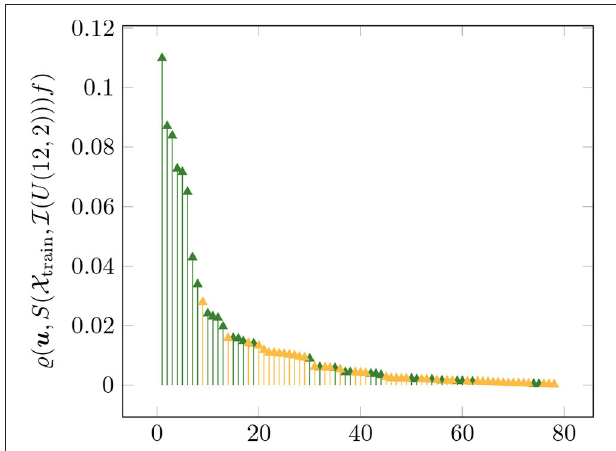
FIGURE 5 | Global sensitivity indices ̺ ( u , S ( X train , I ( U (12,2))) f ), I ( U (12,2)), of the approximation with all twelve attributes using u ∈ N 1 N 2 2 and λ 1.0 (sorted). The green indices belong to sets u such = = = s that 3,7,9 with s u ∃ ∈ { } ∈